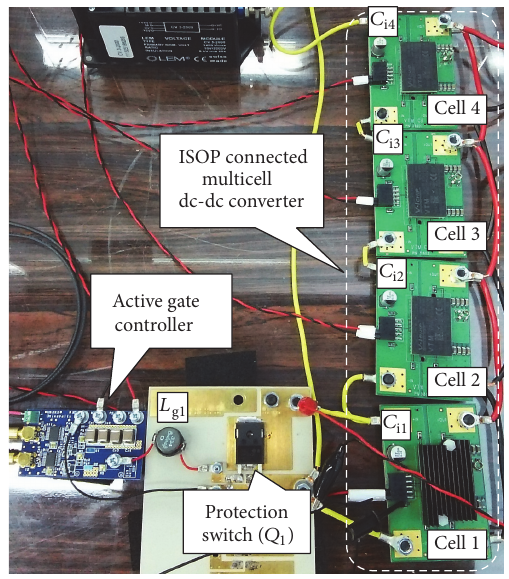
Figure 8: Experimental apparatus for fault tolerant operation of ISOP multicell converter using SiC protection switch.